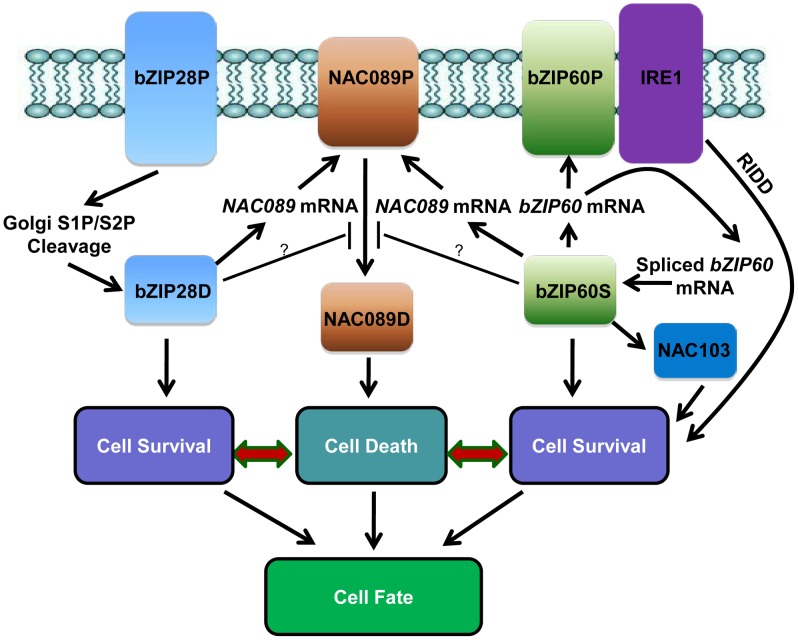
Hypothetical working model of cell survival and cell death pathways in plant UPR.In response to ER stress, the ER-localized bZIP28P is activated through S1P/S2P sequential cleavage. The precursor bZIP60P is also ER membrane-associated under normal growth condition; ER stress activates the ER-localized IRE1, which splices the bZIP60 mRNA to produce a shorter bZIP60 mRNA encoding the activated form bZIP60S. Both the activated bZIP28D and bZIP60S enter the nucleus and up-regulate downstream genes such as molecular chaperones and ERAD components to ensure cell survival. The activated bZIP60S also induces its own transcription and another transcription factor NAC103 to amplify the cell survival signal. IRE1 could also protect cells through RIDD to reduce the entry of secretory proteins into the ER lumen. On the other hand, the ER membrane-localized NAC089P is activated to produce the nuclear form NAC089D when the ER stress is severe. NAC089D activates several downstream PCD-related genes to promote cell death. Both bZIP28D and bZIP60S control the up-regulation of NAC089 under ER stress condition and may also control the expression of negative regulators for NAC089 activation. Thus, both pro-survival and pro-death signals are controlled by bZIP28 and bZIP60, and the balance between their outputs probably decides the life-or-death cell fate in Arabidopsis plants under ER stress conditions.